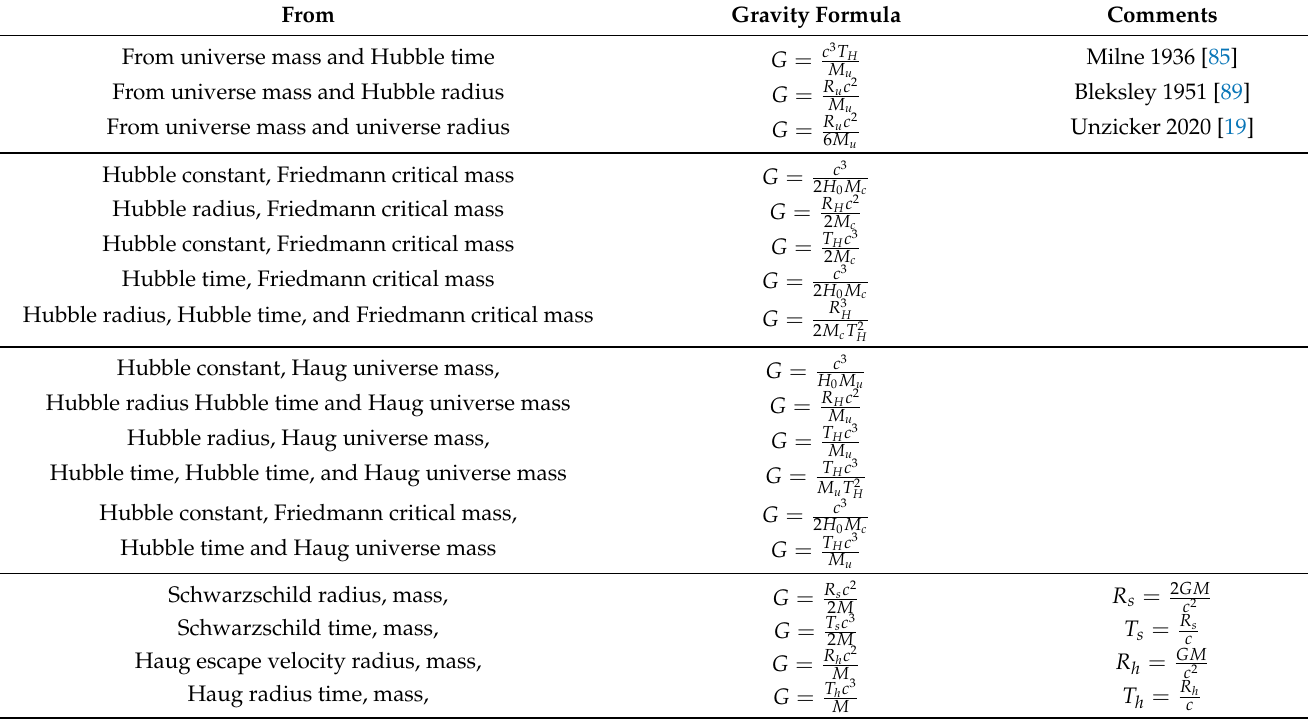
Table 6. The table shows various ways we can express the gravity constant from cosmological units, as well as from units related to black